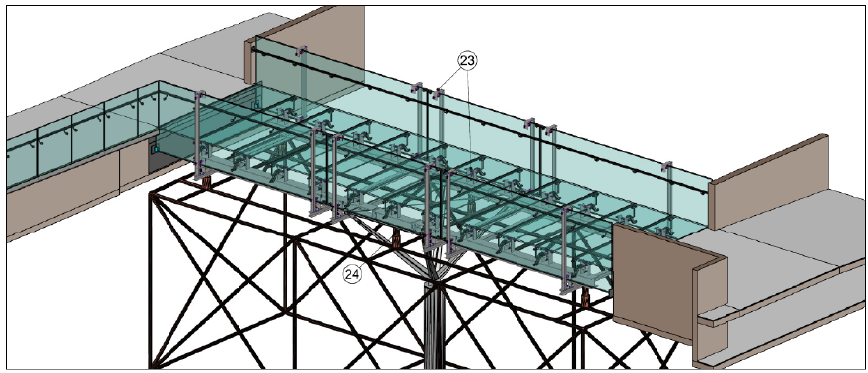
Figure 7: Installation Sequence 13) Installation of the balustrade connection steel